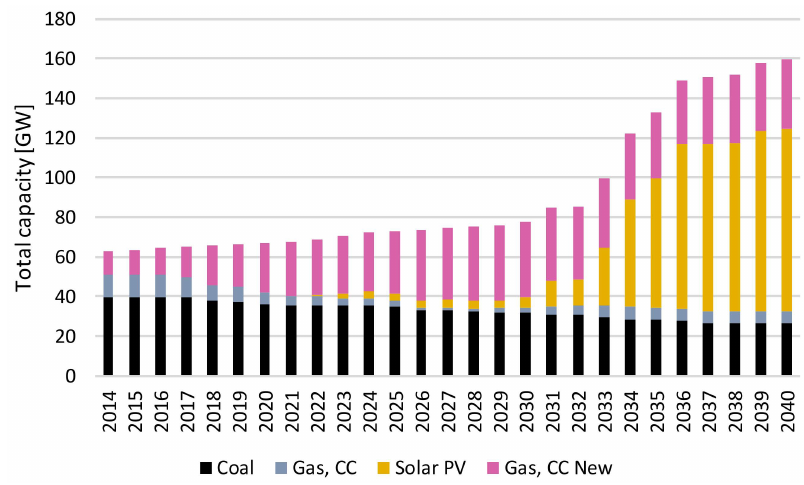
Figure 19. Total capacity (GW) in the REF scenario, in cases of decreasing solar PV capital costs and increasing CO 2 tax—with code